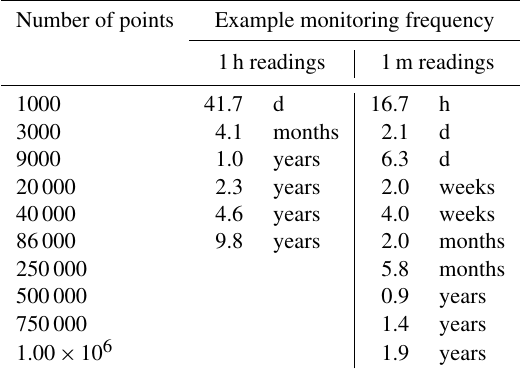
Table 1. Number of points used to generate scenarios and exam- ples of their corresponding time spans represented by the range of x from 0 to 1 if the measurement frequency is known (1h and 1m readings for illustrative